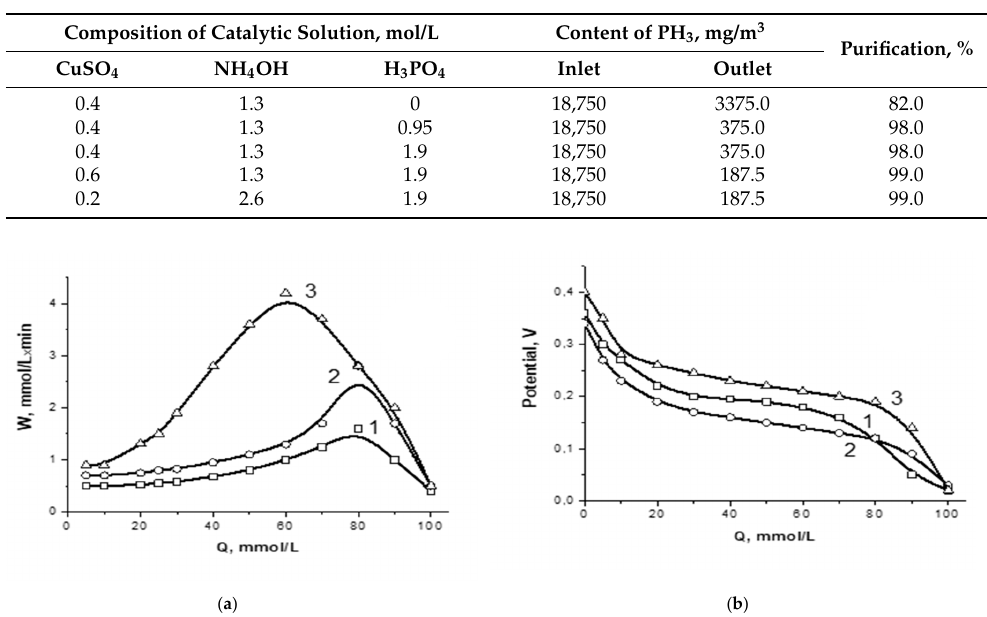
Figure 3. Kinetic ( a ) and potentiometric ( b ) curves of PH 3 oxidation by aqueous copper–ammonia complexes at t = 30 °C, C РН 3in = 2500 mg/ m 3 , X(PH 3 ) = 98–99%, solution composition, mol/L: NH 4 O Н —0.65; Н 3 РО 4 —0.95; and CuSO 4 —0.4; 1–4—cycle number. After the third cycle, purification degree began to decrease (Table 6). The kinetic curves were close, while the potentiometric curves were completely the same (Figure 3a,b). Table 6. Stability of catalyst system of [CuSO 4 ] = 0.4, [NH 4 OH] = 0.65, [ Н 3 РО 4 ] = 0.95 mol/L at t = 30 ° С , C РН 3in = 2500 mg/m 3 .